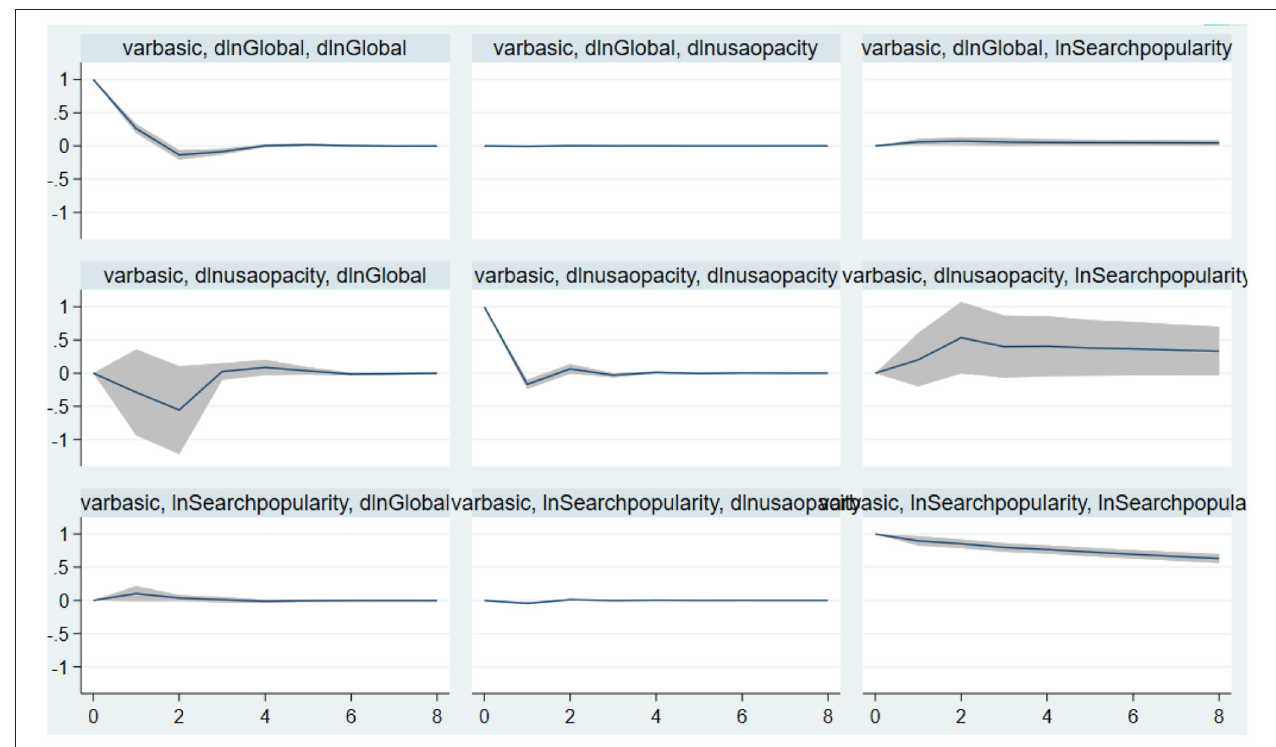
FIGURE 3 | Structural impulse